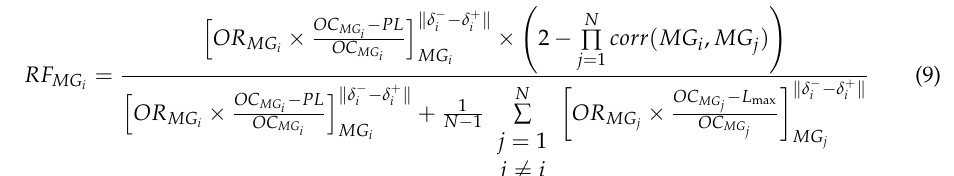
Figure 4. Load profile for each MG of the NMG.